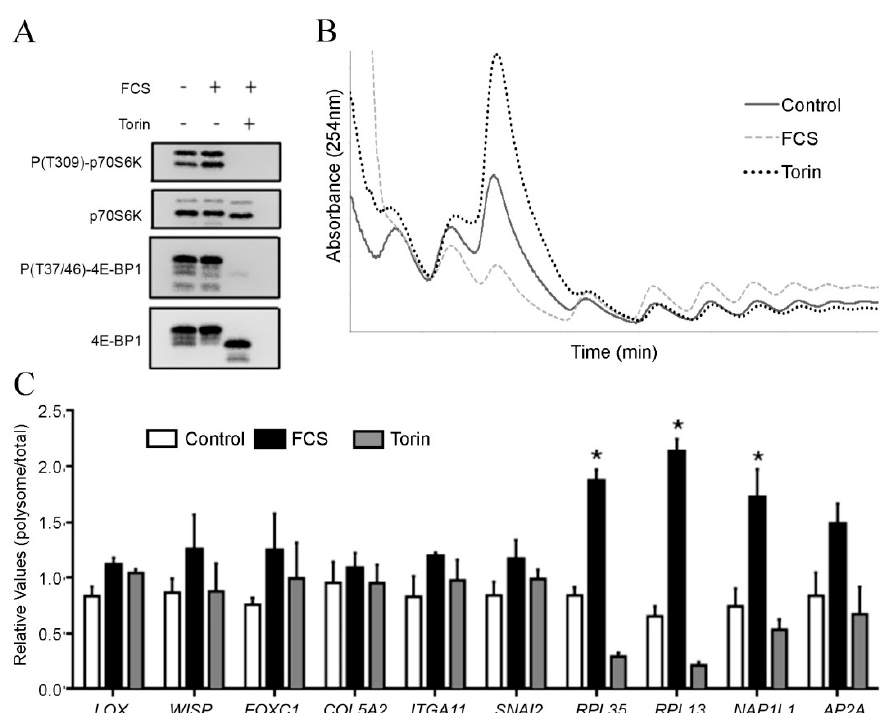
Figure 6. Translation of genes modulated in high ‐ grade fragments are not dependent on mTORC1. U ‐ 87MG GBM cells were serum starved (Control), treated with serum (FCS) and serum plus the mTOR inhibitor Torin1. ( A ) Phosphorylation of mTORC1 targets (p70S6K and 4E ‐ BP) was analyzed by Western blot as readout for mTORC1 activity. Polysome profiles were performed ( B ) and RNA was extracted and used for ( C ) qPCR for genes regulated by translation ( LOX , WISP ), abundance ( FOXC1 , COL5A2 , ITGA11 ), buffering ( SNAI2 ), or whose translation is regulated by mTORC1 ( NAP1L1 , RPL13 , RPL35 and AP2A ). Graph displays the polysome/total ratio of expression for each mRNA. * p < 0.05, One Way ANOVA followed by Tukey’s t test.